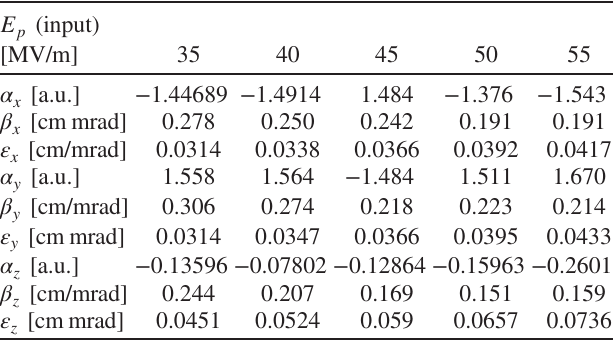
TABLE X. Twiss parameters and RMS emittance at RFQ entrance position determined with RFQGen software obtained when deuteron 5 MeV beam simulation is conducted.